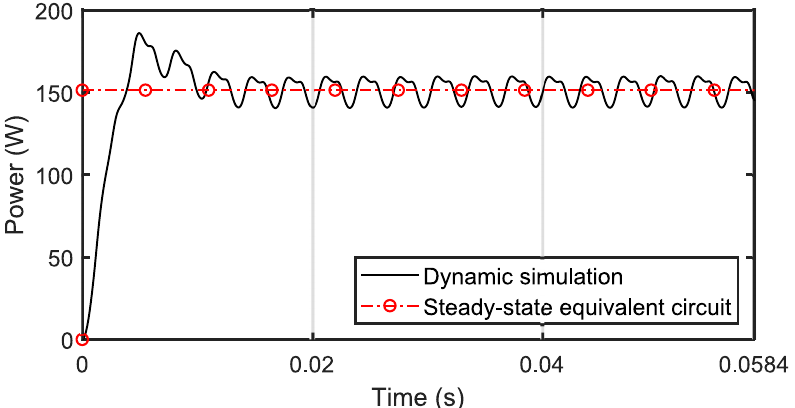
Figure 5. Converted power comparison between proposed steady-state equivalent circuit and dynamic